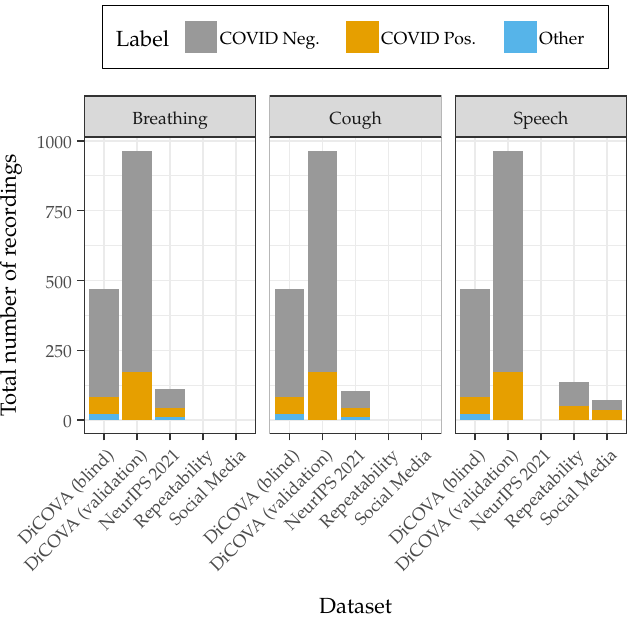
Figure 2. The number of recordings included in each of the five datasets that were used to train and test the COVID-19 detection system. The DiCOVA Blind and NeurIPS 2021 Datasets include subjects with other self-reported respiratory conditions. All recordings were from unique subjects, except for the Repeatability Dataset which included ten replicate recordings from each